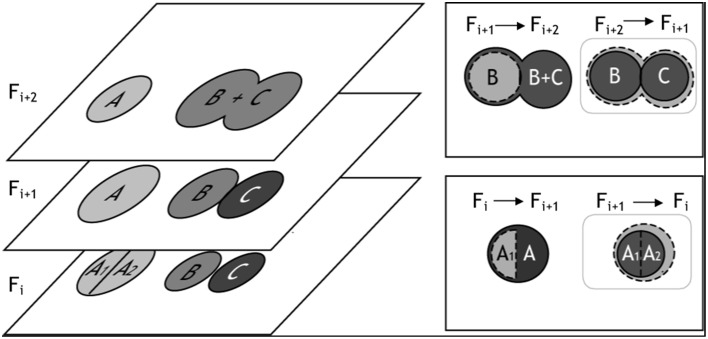
Illustration of 3-D merging and error identification. (Left) This figure exemplifies segmentation results for three cells—A, B, and C—which appear in z-slices/frames Fi, Fi+1, and Fi+2. In Frame Fi+1, we show three correctly segmented somata. In Frames Fi and Frames Fi+2 we illustrate over-and under-segmentation errors, respectively. 2-D objects are merged into 3-D cell bodies if the percentage overlap between the objects is ≥ β, where β can be any number between 0 (no overlap) and 1 (100% overlap). The merging algorithm considers two z-slices/frames at a time, and segmentation errors are identified when multiple objects in a single frame exceed β. (Top Right) For example, cell B from frame Fi+1 was projected into Fi+2. All object(s) in Fi+2 that overlapped with B's projection (dashed cell boundary) were considered as merging candidates; in this case, the object B + C satisfied the percentage overlap criteria. However, the reverse projection of B's best merging candidate, B + C, back onto the previous z-slice/frame identified two objects that satisfied the merging criteria: B and C. Because three objects - B, C, and B + C - were eligible for merging, the under-segmentation error was identified (gray box). (Bottom Right) In a similar fashion, the forward projection of A1 into Fi+1 overlapped best with A; however, the reverse projection of A1's best merging candidate significantly overlapped with two objects: A1 and A2, thus identifying a 2-D segmentation error.